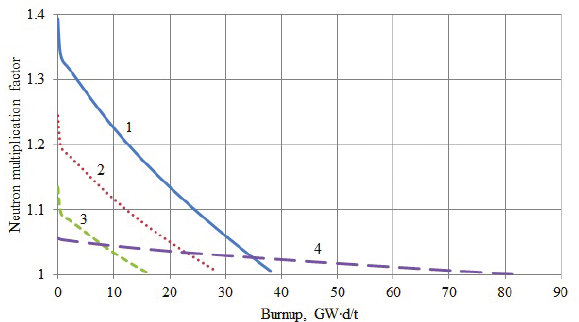
Figure 2. The effect of neptunium on the neutron multiplication factor in the process of fuel burnup: 1) conventional uranium fuel (4.4% of 235 U + 95.6% of 238 U); 2) introducing 1% of nep- tunium (4.4% of 235 U + 94.6% of 238 U + 1% of 237 Np); 3) intro- ducing 2% of neptunium (4.4% of 235 U + 93.6% of 238 U + 2% of 237 Np); 4) introducing a large amount of neptunium (35% of 235 U + 65% of 237